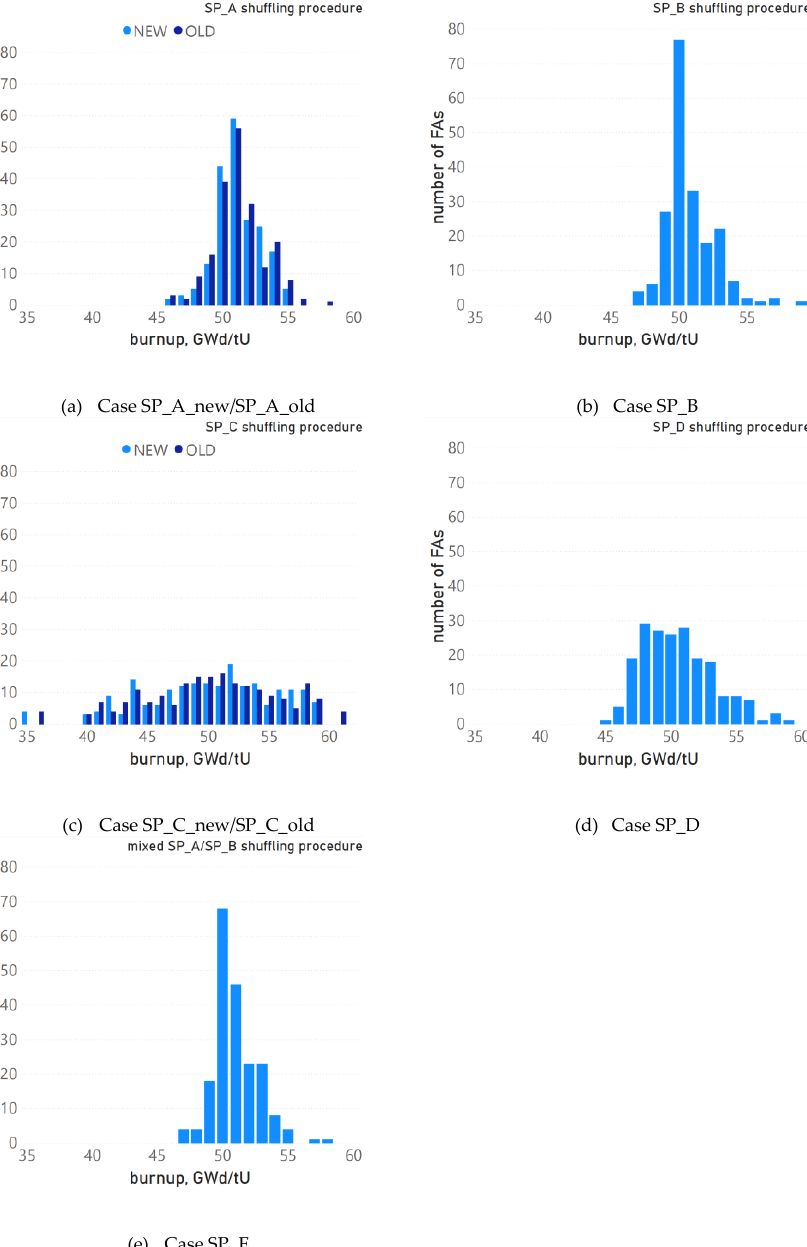
Figure 8. Burnup distribution of the discharged fuel assemblies after four cycles from one quarter of the core for the cases with di ff erent shu ffl ing procedures and core layouts described above: ( a ) SP_A_new / SP_A_old, ( b ) SP_B, ( c ) SP_C_new / SP_C_old, ( d ) SP_D and ( e ) SP_E (NEW—adjusted layout; OLD—reference